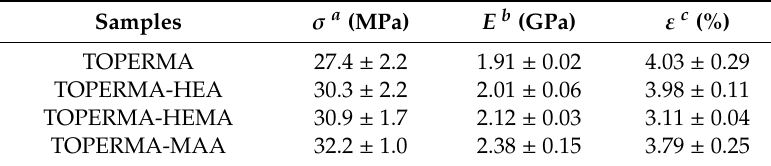
Figure 5. Typical tensile curves of the cured TO-based resins. Table 3. Mechanical properties of the cured TO-based